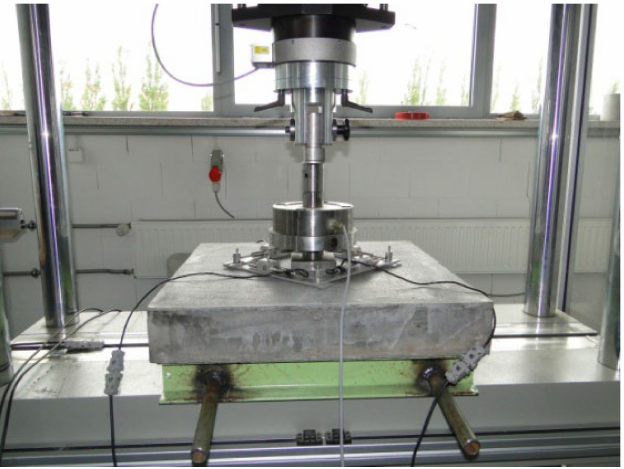
Figure 6. The stand for testing the energy absorption capacity of a fiber